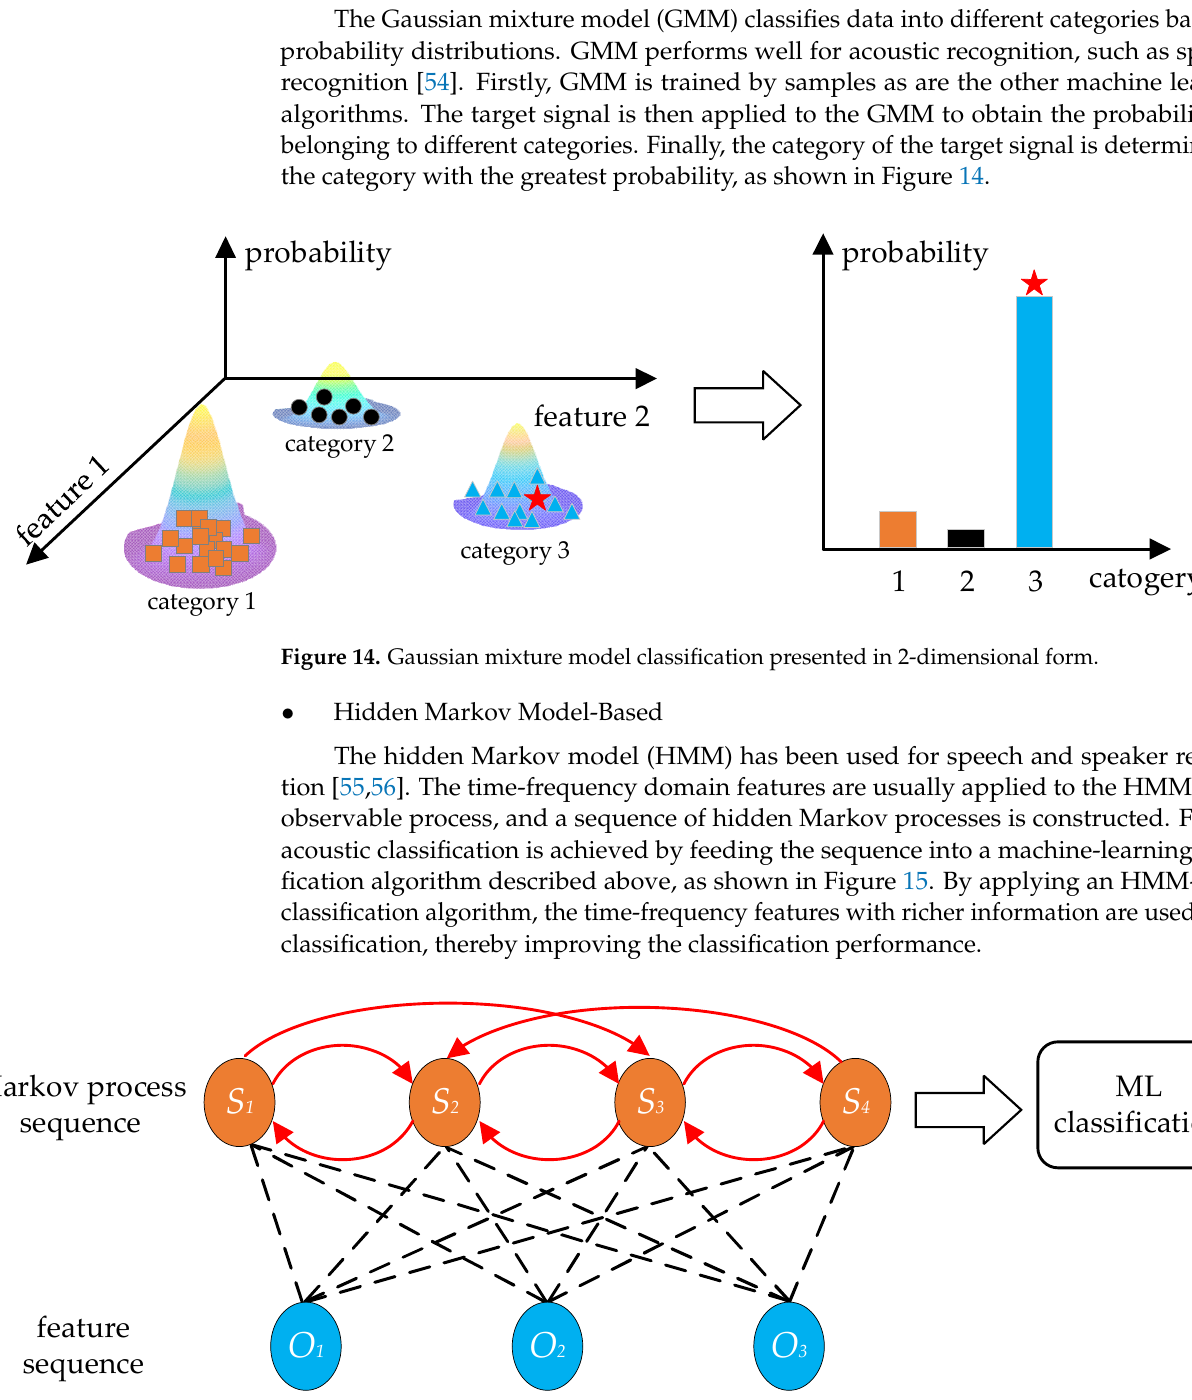
Table 2. Acoustic classification algorithm. Type